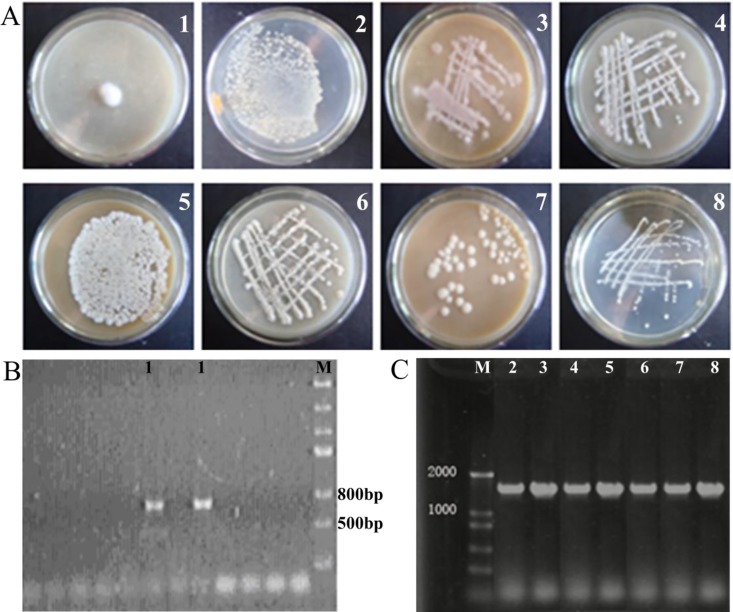
Colony morphology of the dominant strains in the culture medium and electrophoresis atlas of the PCR products amplified from apple fruit fermentation (AFF).(A), colony morphology. 1, Coprinus atramentarius (Bull.) Fr. 2, Bacillus megaterium. 3, Bacillus licheniformis. 4, Weissella. 5–8, Bacillus subtilis. (B, C), PCR amplification from apple fruit fermentation (AFF).